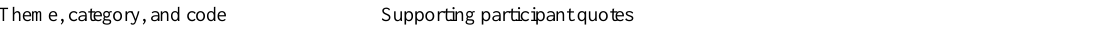
Table 2. Qualitative results from resident interviews.